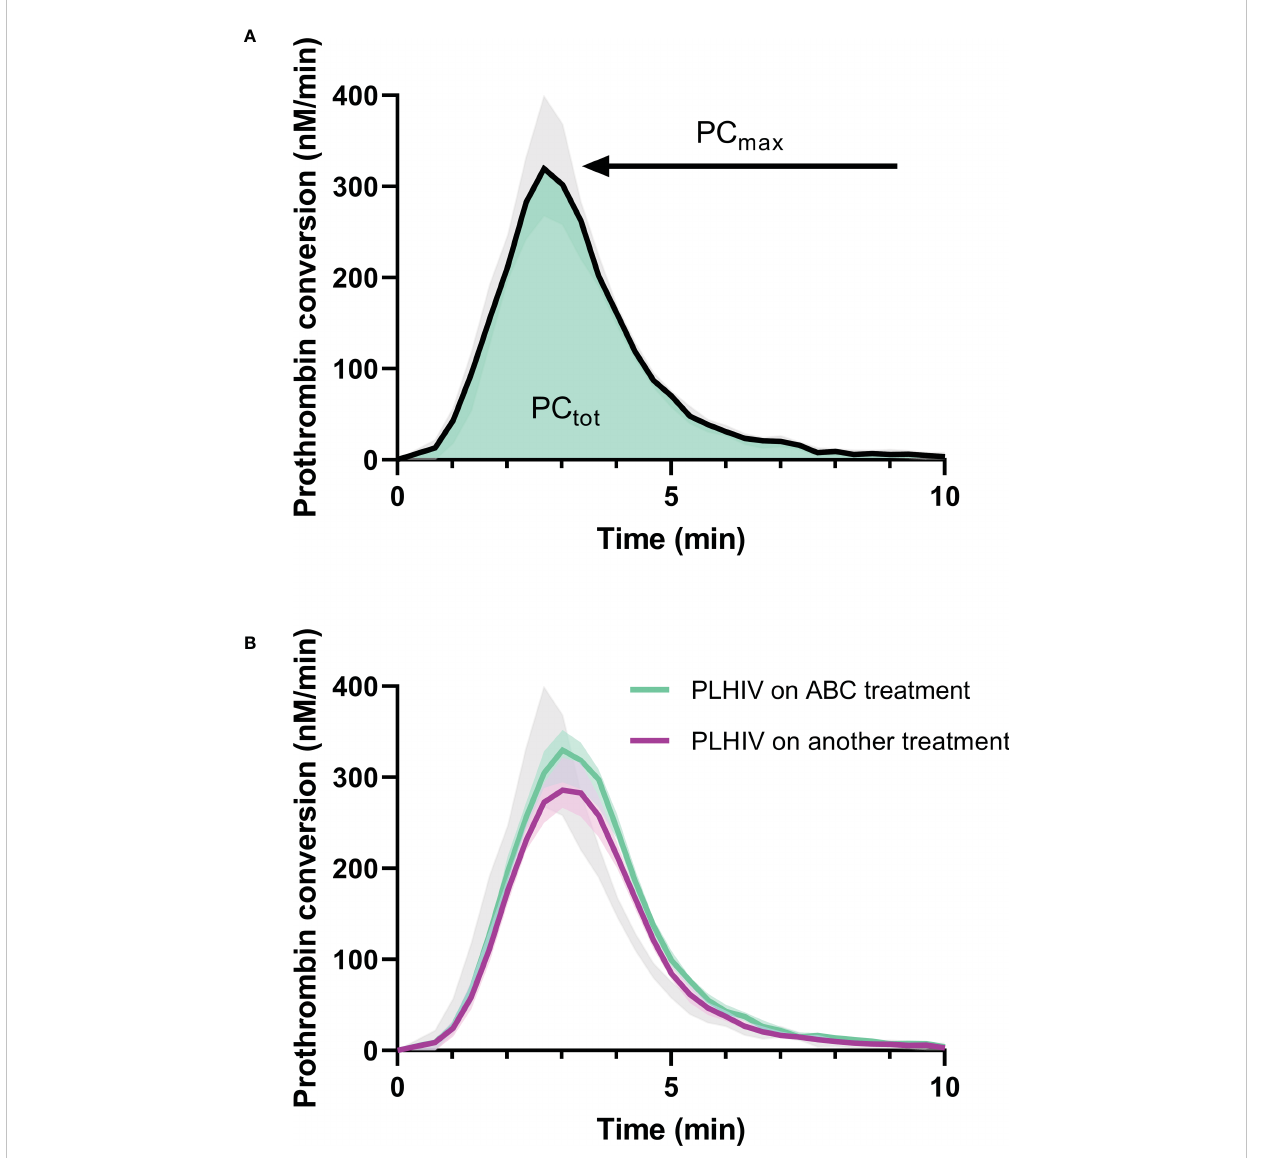
FIGURE 3 Prothrombin conversion curves in PLHIV and controls without HIV. (A) The median prothrombin conversion curves in controls without HIV with the 95% con fi dence interval marked as grey shading. The quanti fi cation of prothrombin conversion parameters PC tot (area-under-the-curve, green) and PC max (peak height of the curve) are indicated. (B) The median prothrombin conversion curves in PLHIV on ABC treatment (green) and PLHIV on other treatment regimens (purple), each with their 95% con fi dence interval depicted as shading. The 95% con fi dence interval of the controls without HIV is indicated in grey for